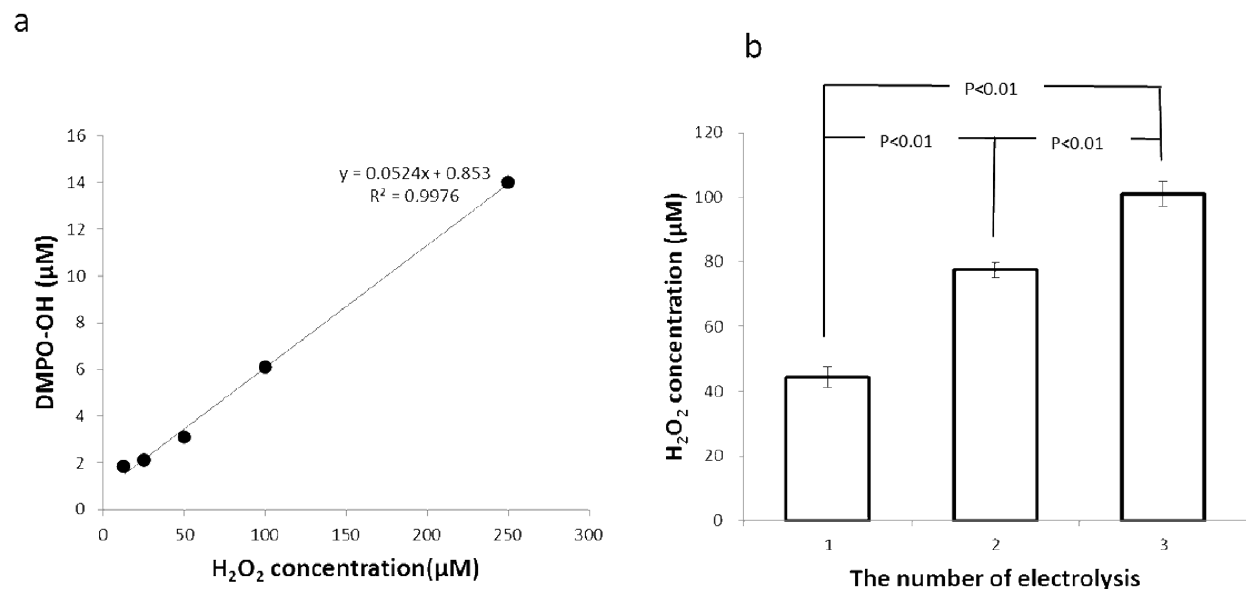
Figure 4. Determination of hydrogen peroxide concentrations. Calibration curve for determining hydrogen peroxide concentration (a) and hydrogen peroxide concentrations in AEW prepared by single and repeated electrolyses of 1% NaCl solution (b). Each value in the graph in (b) represents the mean 6 standard deviation ( n =3). Tukey–Kramer’s multiple comparison test was conducted for the hydrogen peroxide concentrations.